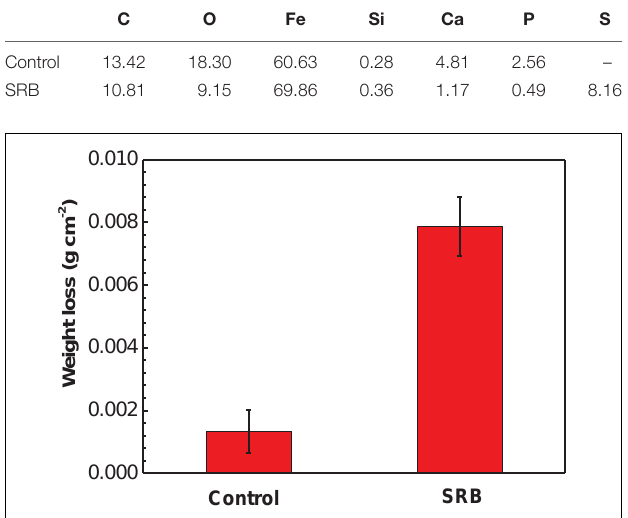
TABLE 3 | Energy dispersive x-ray spectrum analysis results of corrosion product film and SRB biofilm on specimens after 14-days of incubation in the absence and presence of SRB, respectively.